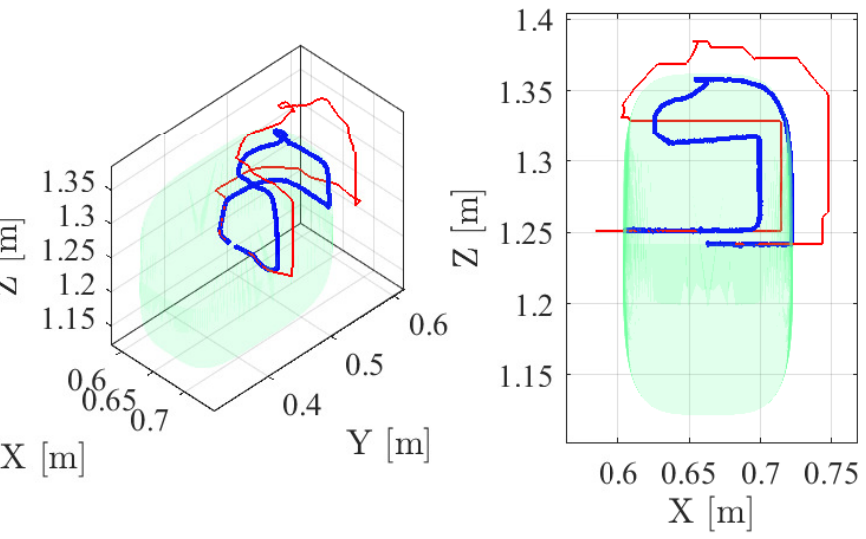
Figure 14. The 3D trajectory performance for the third experiment, showing the 3D boundary and the WR reference hologram (see the video at https://media.upv.es/player/?id=17d88200-8f0b-11ec-be2 2-d786eca82090 (accessed on 26 April 2022) [83]): 3D allowed region in green; trajectory followed by the user reference in thin red line; and trajectory followed by the WR end-effector in thick blue